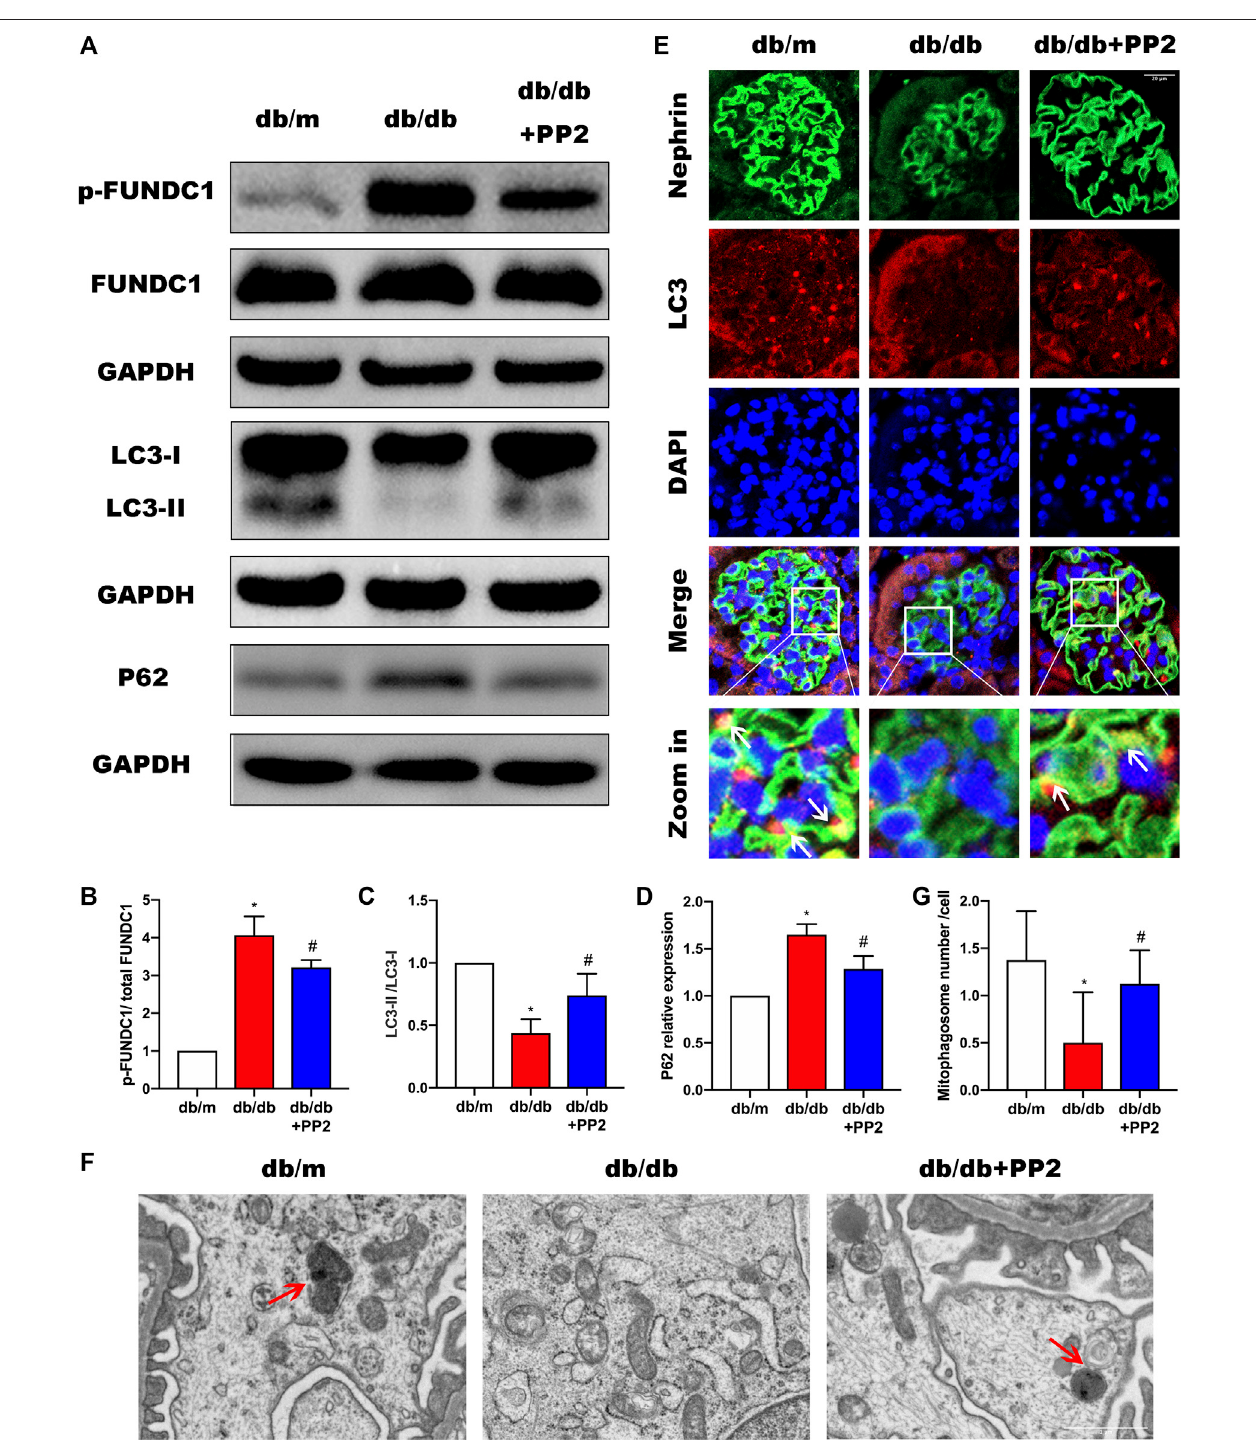
FIGURE3| InhibitionofSrcactivityincreasesmitophagyduringDN. (A) TheexpressionlevelsofFUNDC1,p-FUNDC1,LC3,P62inkidneytissuesfromthedifferent groups wereanalyzedbyWestern blot. (B – D) Quantitativeanalysisofgray valuesofbandsfromWestern blots,GAPDHwasusedasloadingcontrol. (E) Representative images of LC3 (red) staining in glomeruli in kidney tissues from the different groups. Podocytes were marked by Nephrin staining (green). (Magni fi cation, 600 ×). (F) Representative TEM images demonstrating mitophagosomes (mitophagosomes engul fi ng mitochondria) in podocytes from the different groups. Red arrows denote typical mitophagosomes. (Magni fi cation, 5000 ×). (G) Quanti fi cation of mitophagosomes numbers from the experiment in (F) . Values are expressed as the mean ± SD, * p < 0.05 vs. db/m group; # p < 0.05 vs. db/db group. n = 5.